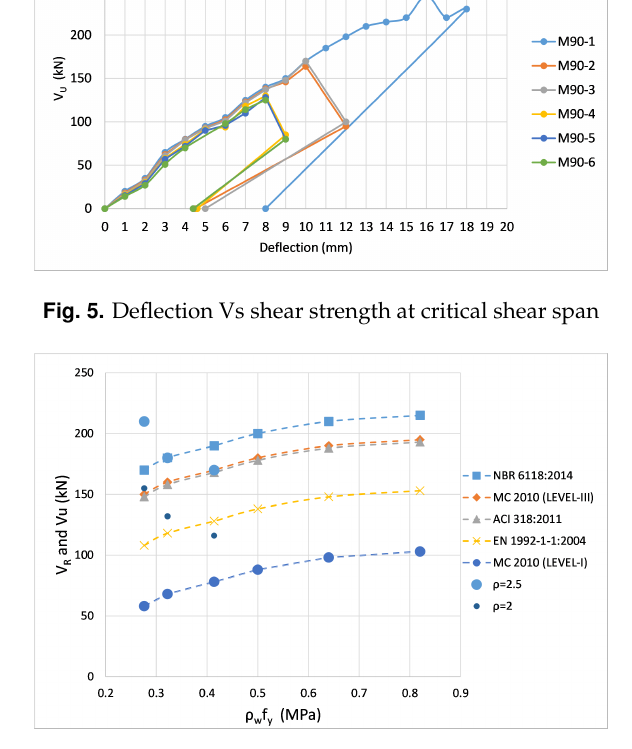
Fig. 6. Experimental results and calculated shear